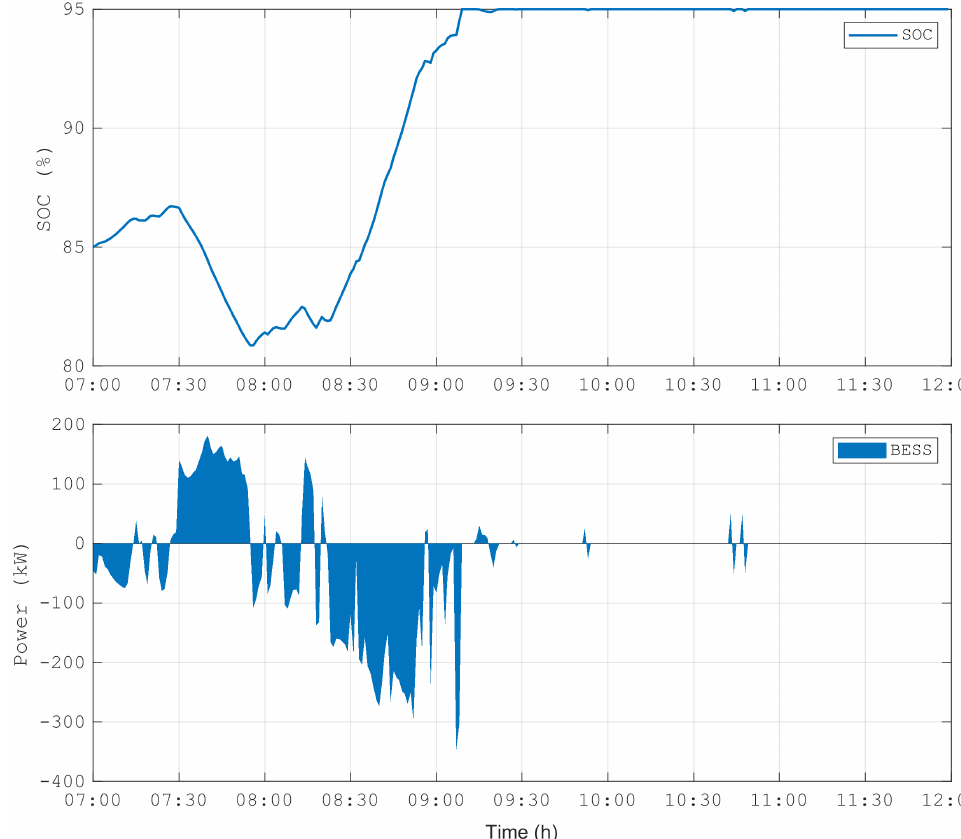
Figure 8. SOC variation and BESS injected/absorbed power for off-grid operation (base case).